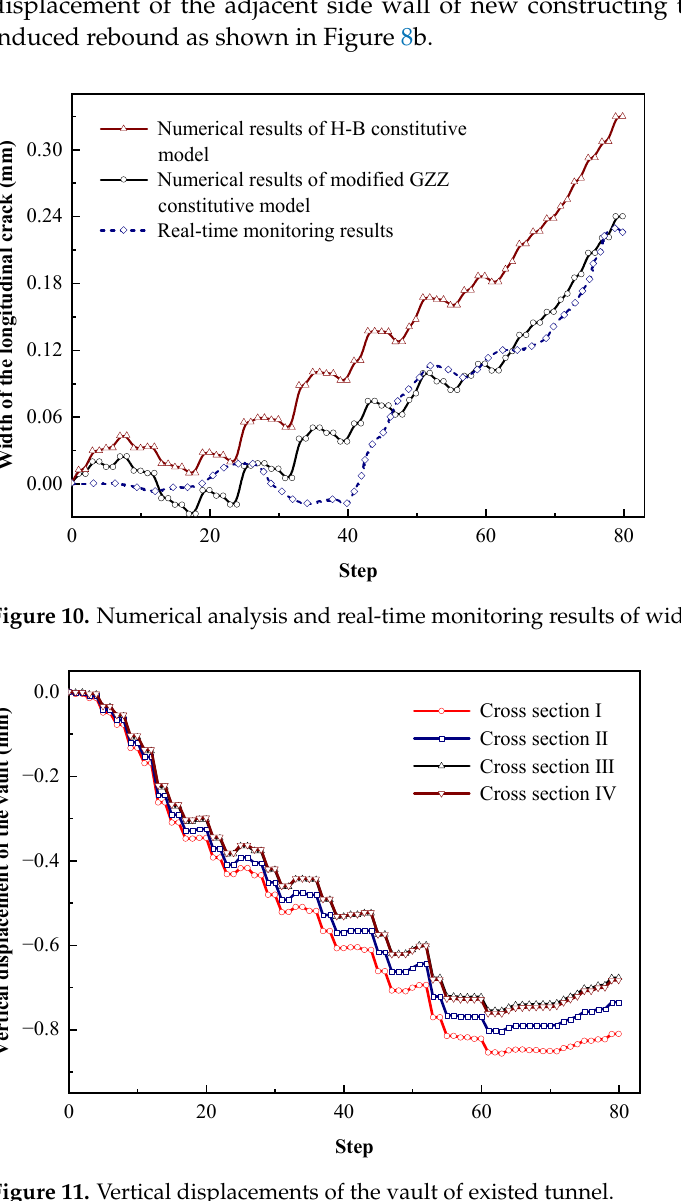
Figure 11. Vertical displacements of the vault of existed tunnel. 4.3.3. Horizontal Displacement of Adjacent Side Wall of Existed Tunnel